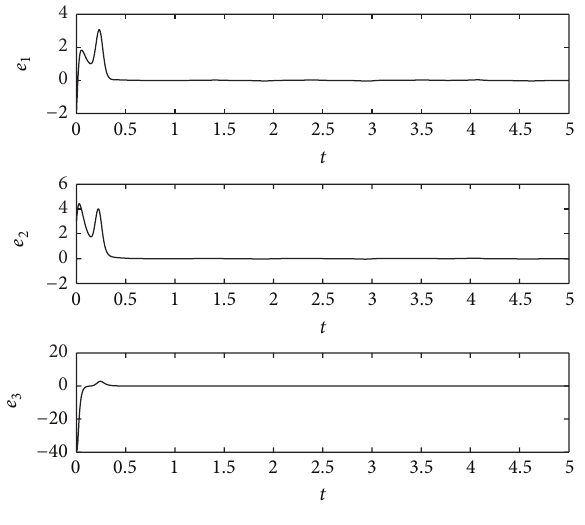
Figure 8: Synchronization errors with time 𝑡 .